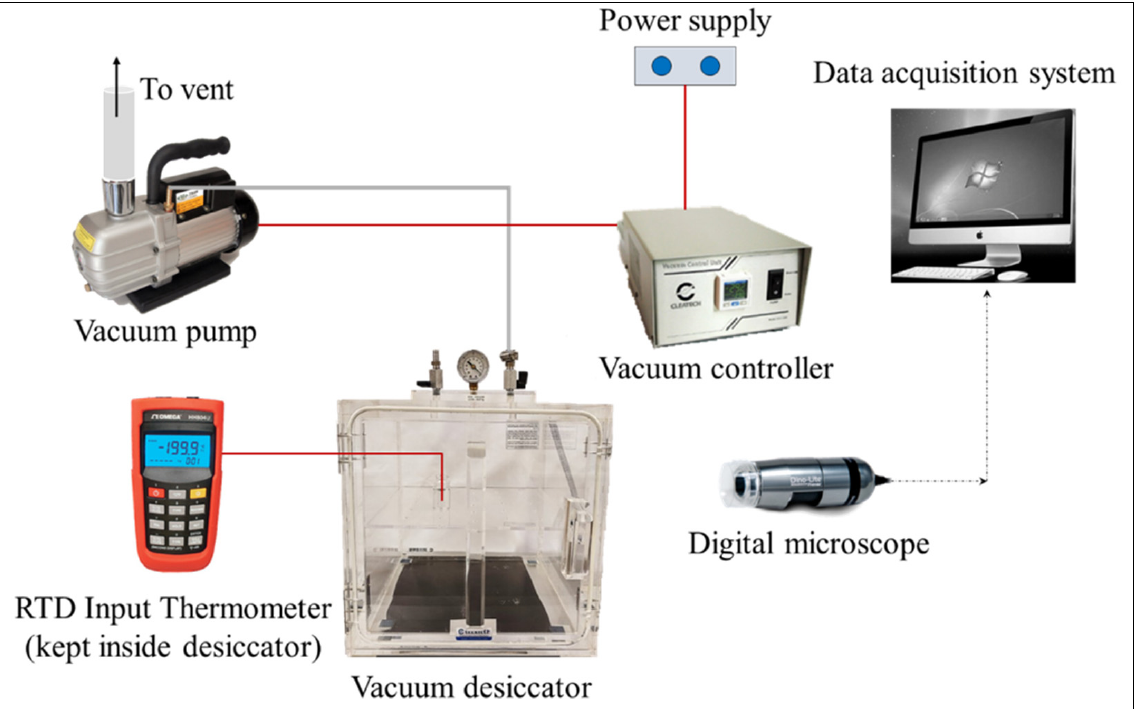
Figure 2. Experimental facility used for bubble nucleation experiments at sub ‐ atmospheric pressure.